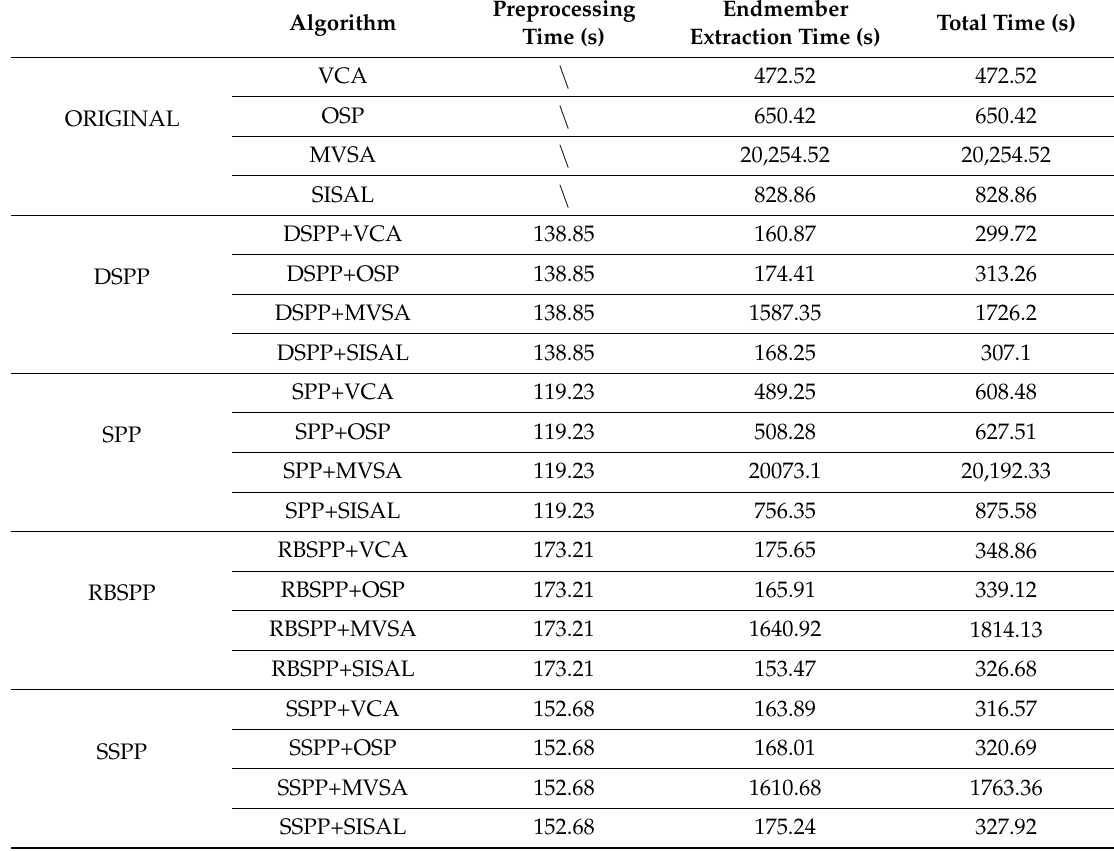
Table 6. Processing time comparisons using different